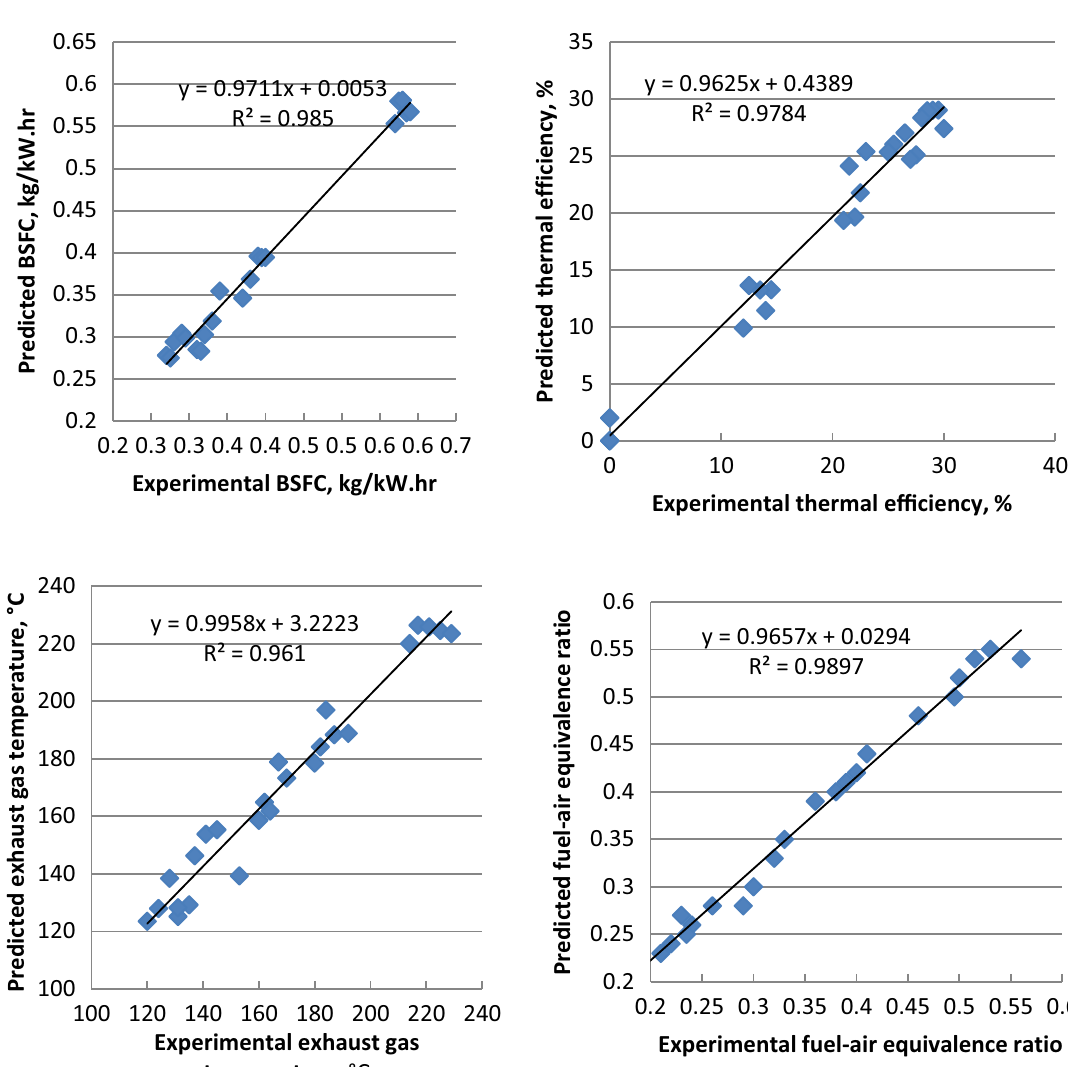
Figure 14. Correlation between ANN model and experimental values of BSFC, BTE, T exh and fuel- air equivalence